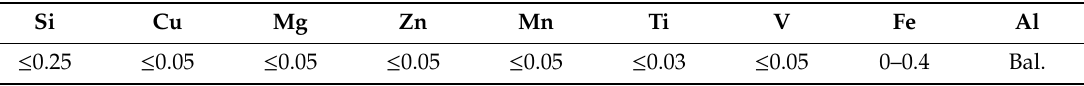
Table 1. Chemical compositions of the 1060 aluminium alloy (wt%).